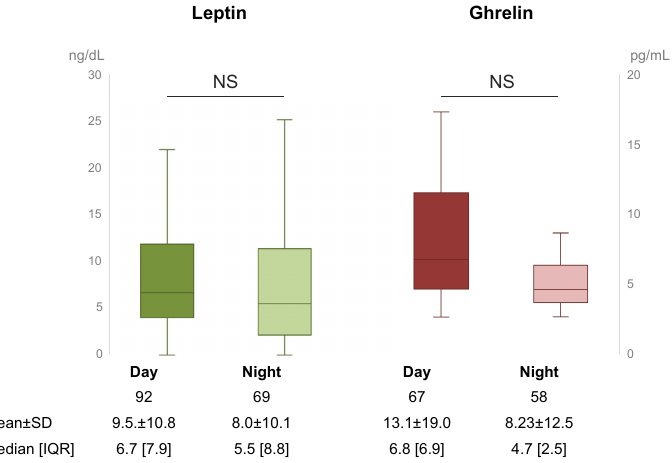
Figure 2. Median [interquartile range] salivary levels of leptin and ghrelin before the beginning of a day shift and at the end of a night shift. The results of leptin are expressed in nanograms per deciliter. Results of ghrelin are expressed in picogram per milliliter. Ng = nanogram, pg = picogram, dL = deciliter, mL = milliliter, NS = not significant, n = number of samples studied, SD = standard deviation, IQR = interquartile range.